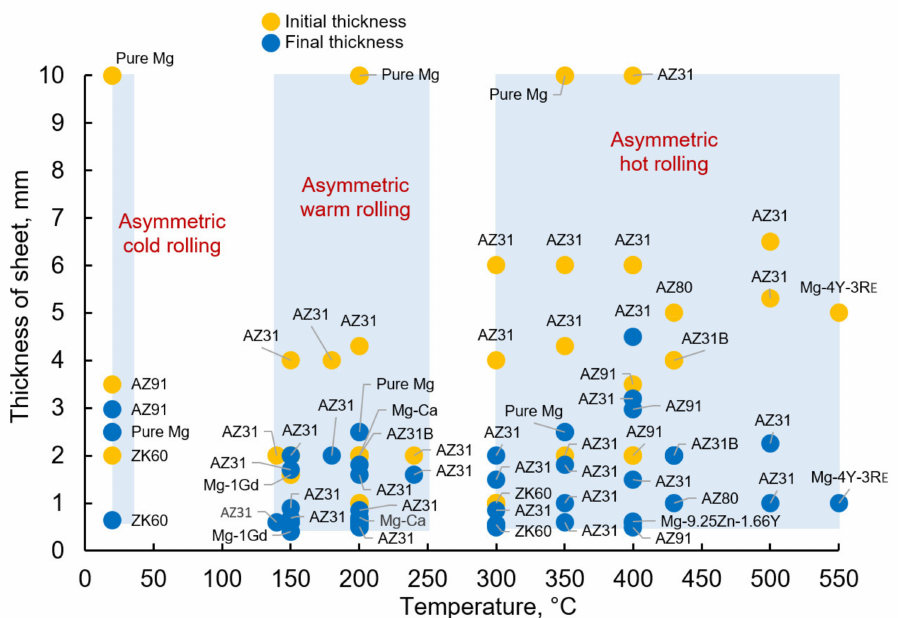
Figure 34. Different Mg alloys, which were processed by asymmetric (hot, warm, cold) rolling (based on data from Tables